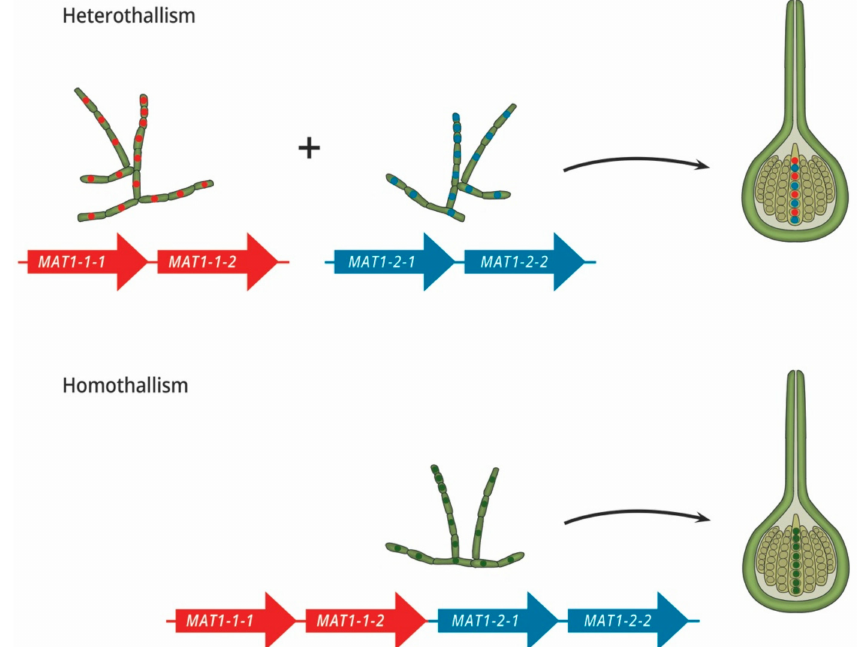
Figure 2. The sexual strategies of filamentous ascomycetes. Heterothallism: Two isolates of an opposite mating type need to physically interact in order to produce sexual structures. These mating types are genetically determined by genes at the MAT locus, either encoding the MAT1-1 genes (red) or the MAT1-2 genes (blue). These genes confer the MAT1-1 and MAT1-2 mating identities, respectively. Homothallism: Sexual reproduction can either occur within a single isolate that expresses both the MAT1-1 and MAT1-2 genes (as illustrated) or between any two individuals of the same species. In Podospora anserina , the sexual cycle is controlled by a variety of proteins that regulate the MAT genes. One of the most prominent MAT -regulating proteins is encoded by pro1 , a gene that is very well characterized in a number of model fungi [17–20]. In P. anserina , this protein regulates similar pathways to those of other fungal species, but also plays an integral role in sexual reproduction [21]. Pro1 acts as a positive regulator upstream of a high mobility group (HMG) box protein named PaHMG8, which itself positively regulates the expression of both MAT1-1-1 and MAT1-2-1 [21,22]. In addition to PaHMG8, two other HMG box proteins, PaHMG5 and PaHMG6, are also responsible for the tight regulation of the two MAT genes and their transcription networks [22]. Transcription factors that possess the HMG box domain are involved in a multitude of biological processes, with a particular importance in pathways associated with sexual reproduction in fungi